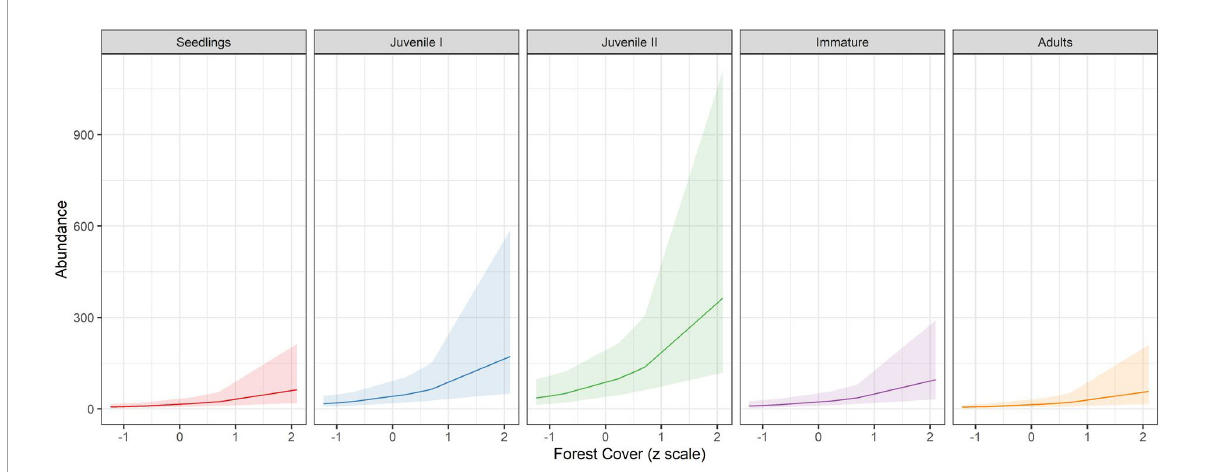
FIGURE3 Relationship between forest cover (z scale) and E. edulis ontogenetic stages. The 95% confidence intervals around linear fit are shown in gray.